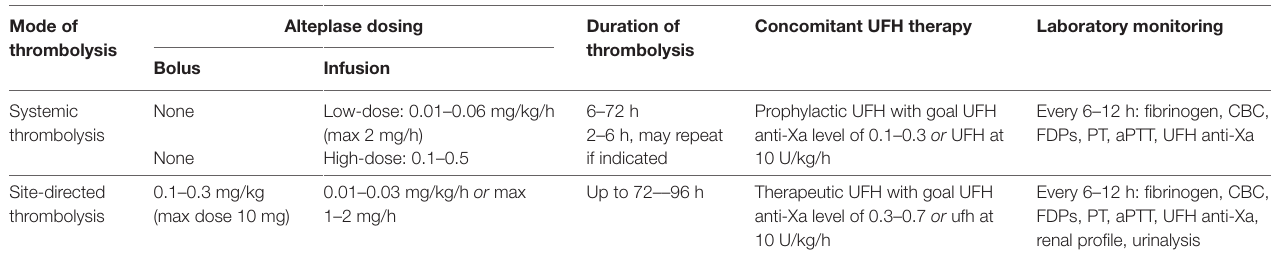
TABLe 2 | Dosing of alteplase and heparin during